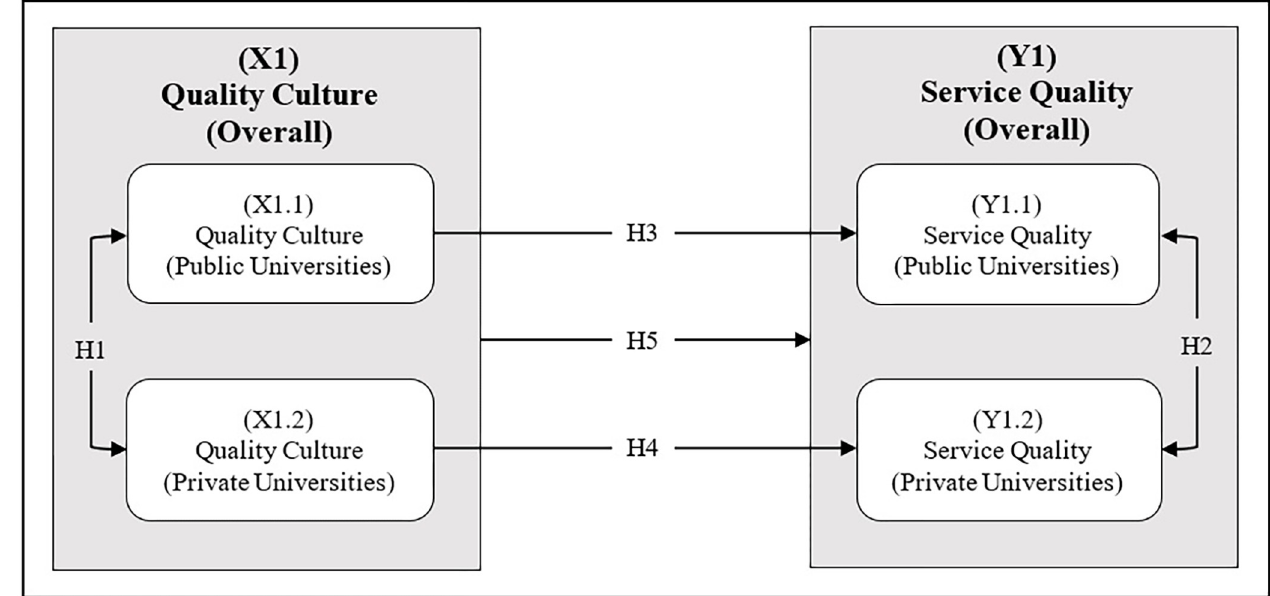
Fig 1. Conceptual